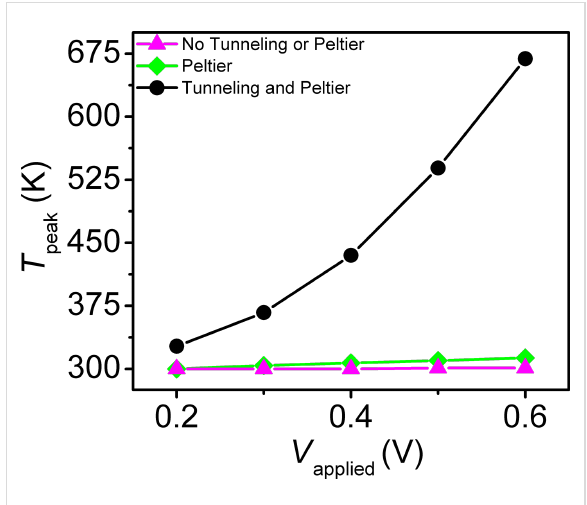
Figure 9: Individual heat contributions from Peltier effect and tunnel- ing around the MTJ for configuration I with SiO 2 passivation